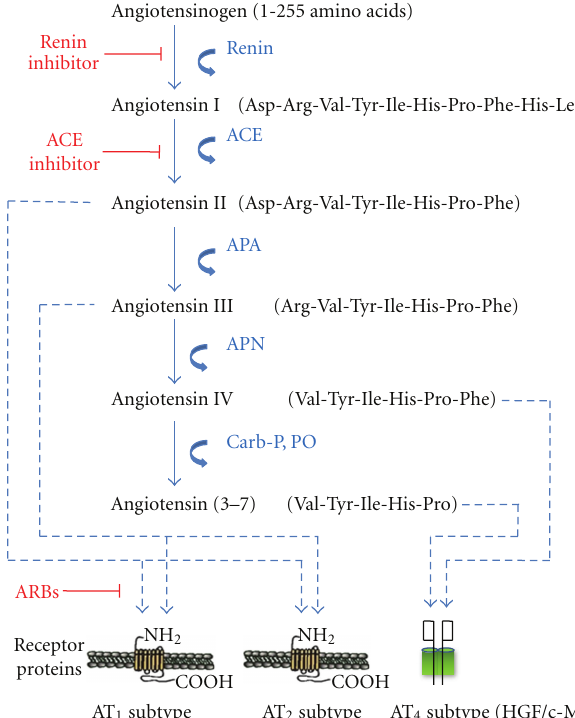
Figure 1: Description of the peptide structures and enzymes involved in the conversion of angiotensinogen to angiotensin I through shorter angiotensins. The biologically active forms include angiotensins II, III, IV, and angiotensin (3–7). The respective receptors where these angiotensins bind are indicated by arrows. The locations of action of angiotensin inhibitors are also indicated. Abbreviations: ACE = angiotensin converting enzyme; APA = aminopeptidase A; APN = aminopeptidase N; ARB = angiotensin receptor blocker; Carb-P = carboxy peptidase P; PO = propyl